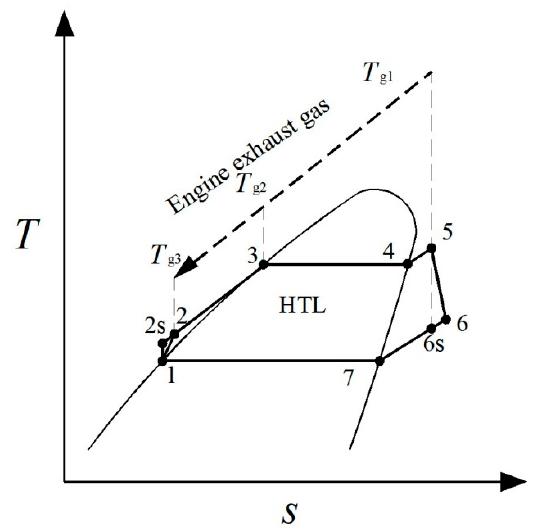
Figure 2. High-temperature loop (HTL) T - s diagram.